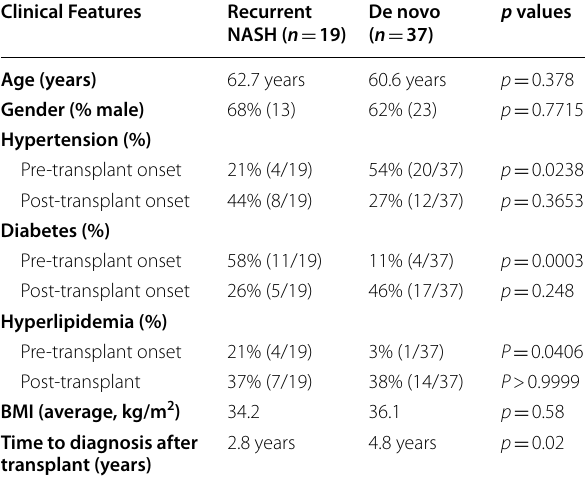
Table 2 Clinical features of recurrent versus de novo NASH